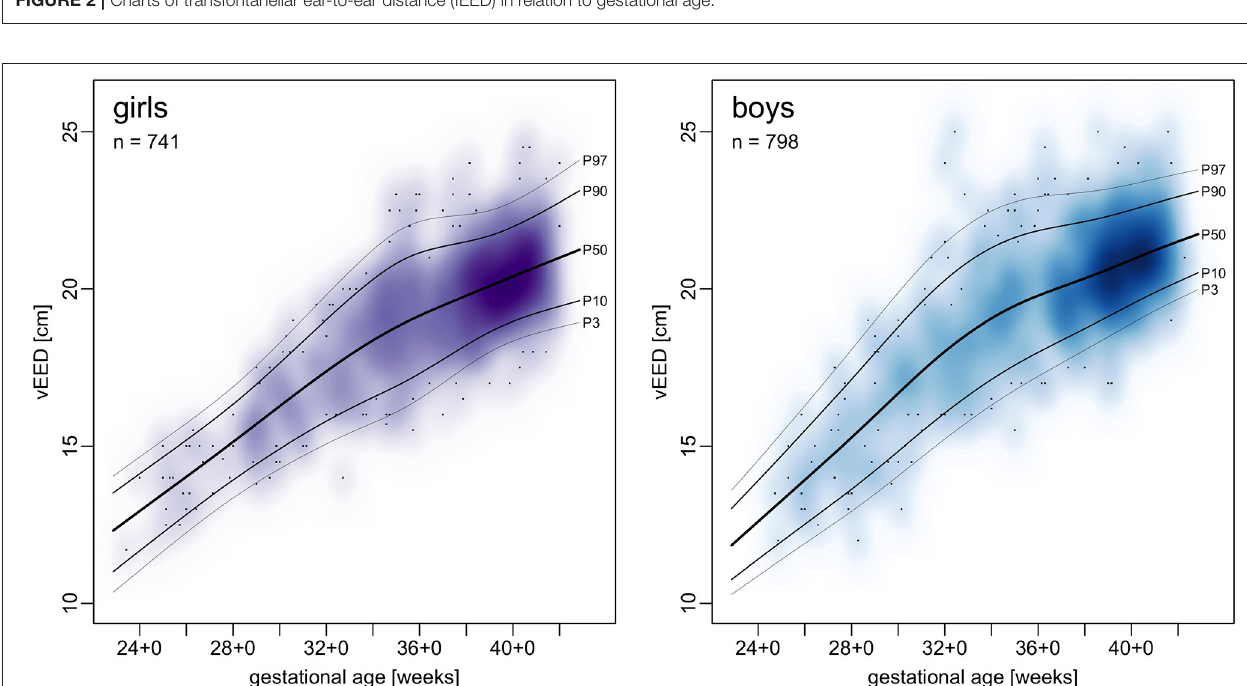
FIGURE 2 | Charts of transfontanellar ear-to-ear distance (fEED) in relation to gestational age.